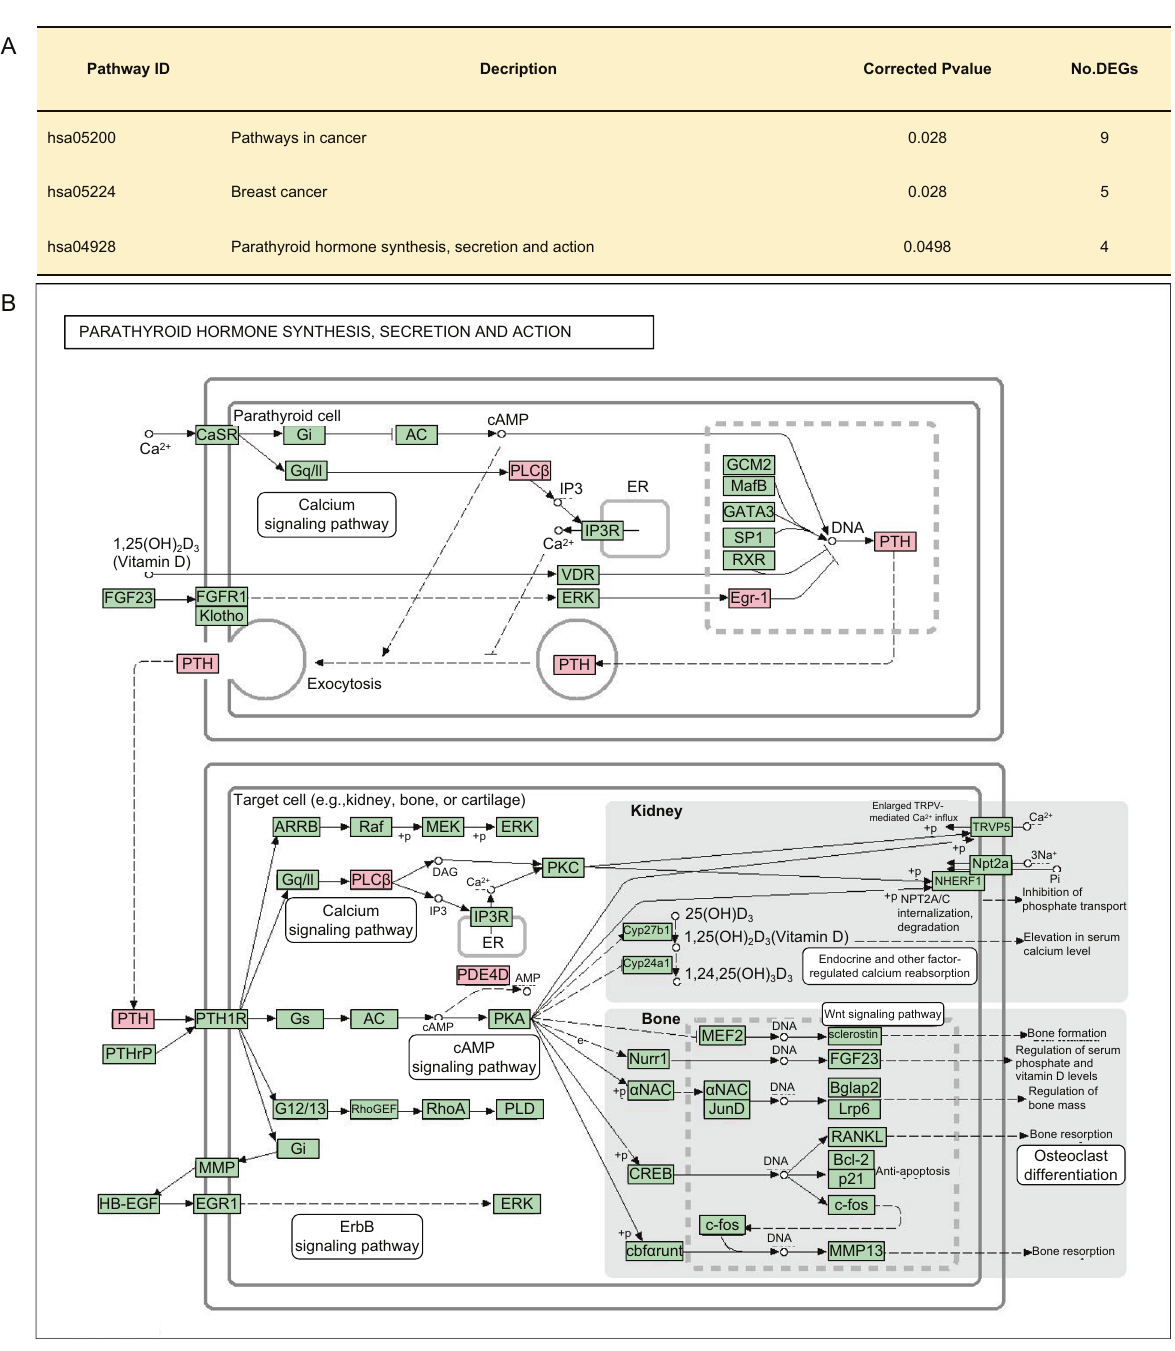
Fig. 3 KEGG enrichments of DEGs in protein-protein interaction network (PPI). A There are three signi fi cant pathways, which are pathways in cancer, breast cancer, and parathyroid hormone synthesis, secretion, and action. B Schematic diagram of parathyroid hormone synthesis, secretion, and action. The genes in the pathway are labeled in red, which are PTH , PLCB4 , EGR1, and PDE4A